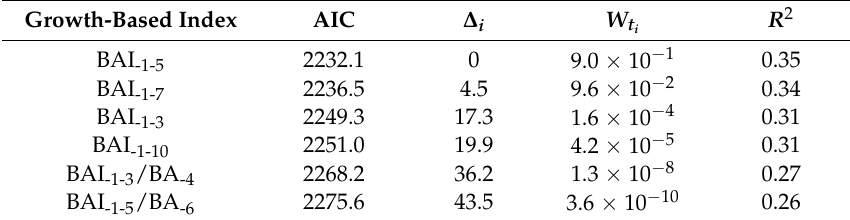
Table 2. Statistics for the best linear mixed models that related the growth efficiency index to different growth-based indices. All models also include an intercept, tree species (the fixed effect), and a random site effect.